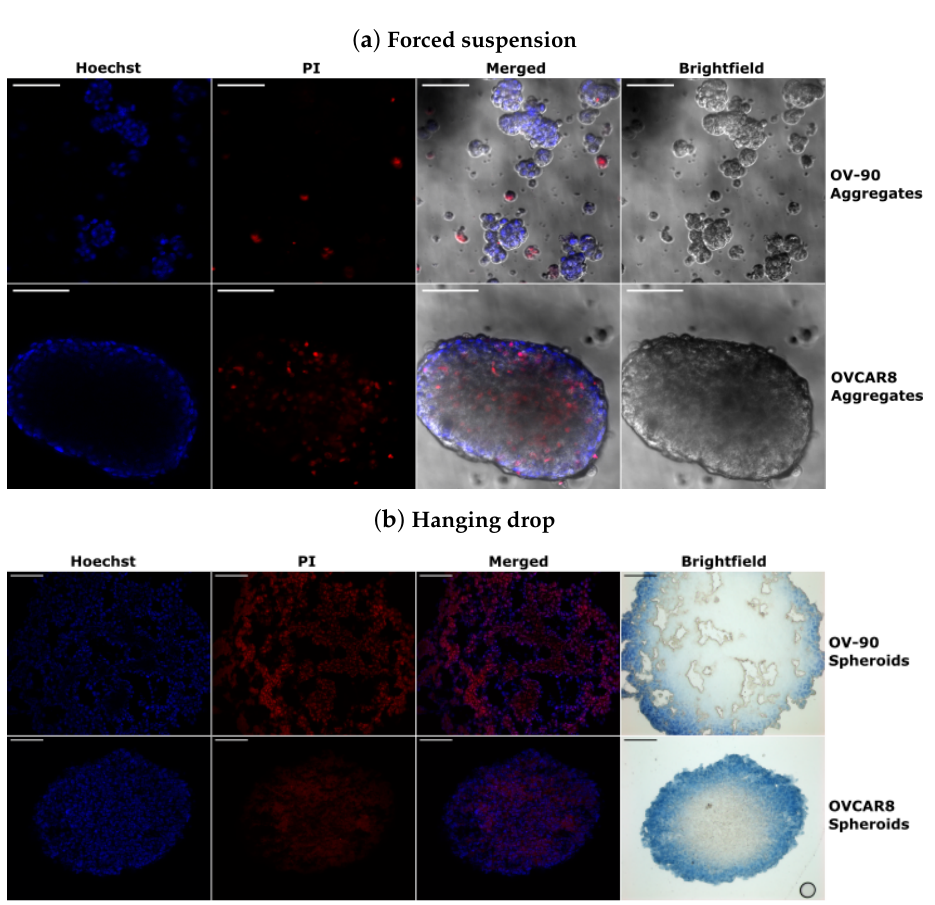
Figure 5. Representative fluorescent confocal microscopy images of 7-day-old aggregates produced by polyHEMA culture showing a comparison of OV-90 and OVCAR8 aggregates with propidium iodide staining (red), Hoechst 33342 staining (blue), merged and brightfield image ( a ). Representative images of 8 µ m sections from the centre of 7-day-old OV-90 and OVCAR8 spheroids produced by hanging drop culture with propidium iodide staining (red), Hoechst staining (blue), merged image and brightfield image with aniline blue staining, taken using a Zeiss fluorescent microscope ( b ). Brightfield images were taken separately. Scale bar is 100 µ